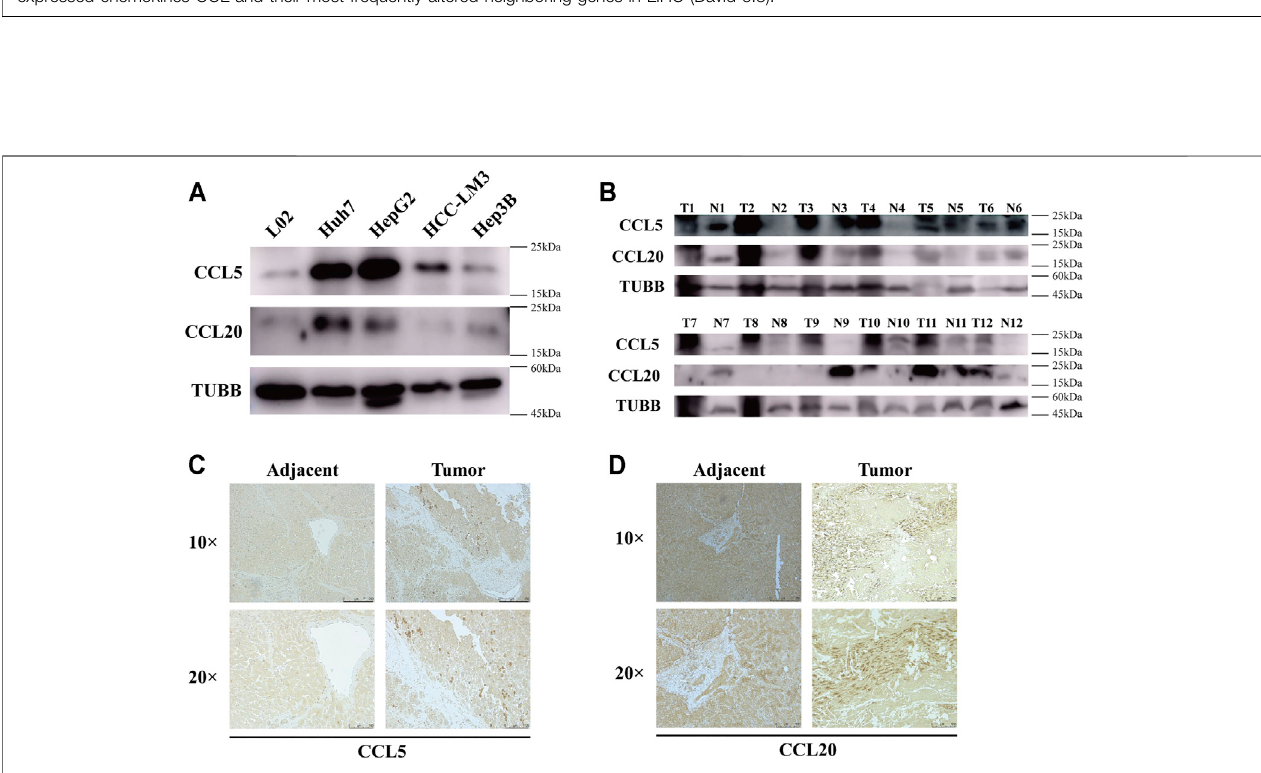
FIGURE 8 | CCL5 and CCL20 expressions are increased in HCC cell lines and tumor tissues. (A) The protein levels of CCL5 and CCL20 in 4 HCC cell lines and human liver normal cell line determined by Westernblot; TUBB was used asa control. (B) The protein levels of CCL5 and CCL20 in 12 HCC tissuesand paired adjacent tissuesdeterminedbyWesternblot. (C) RepresentativeimagesofCCL5immunohistochemicalstaininginHCCtissuesandpairedadjacenttissues.Scalebar (cid:1) 250and 100 μ m, respectively. (D) Representative images of CCL20 immunohistochemical staining in HCC tissues and paired adjacent tissues. Scale bar (cid:1) 250 and 100 μ m,